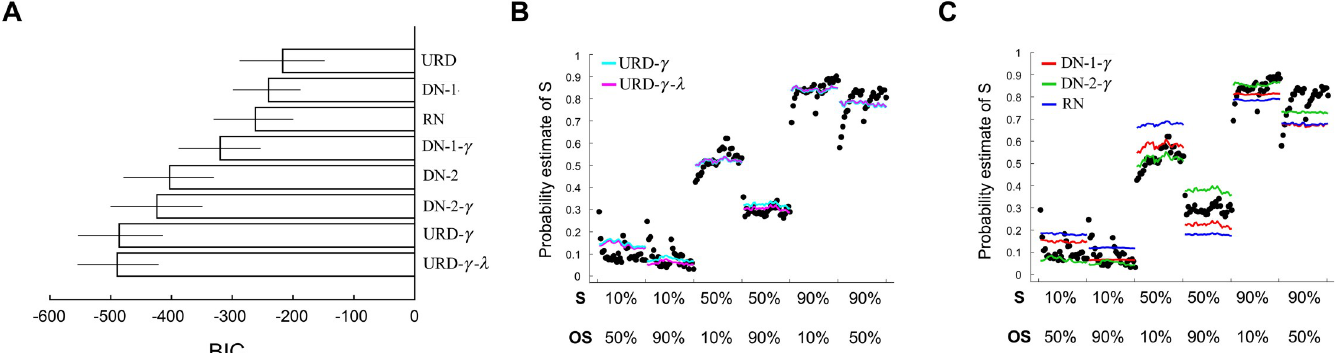
Fig 7. Model fitting results: Group average data. (A) Model comparison. We show BIC value of 8 models. Smaller BIC values indicate better models. Error bars represent 95% bootstrap confidence interval. (B) Model fitting results of the URD models (URD- γ ,URD- γ - λ ). (C) Model fitting results of the divisive normalization models (DN-1- γ ,DN-2- γ ) and range normalization model (RN). Each data point (black) in panels B and C represents the mean probability estimate (across all subjects) of a particular trial order. For example, in the [10%, 50%] context, when S is the 50% reward stimulus, OS would be the 10% reward stimulus; when S is the 10% reward stimulus, OS would be the 50% reward stimulus. Data underlying these graphs can be found in https://osf.io/48j7m. BIC, Bayesian information criterion; DN, divisive normalization; OS, the other stimulus present in the same context as the stimulus of interest; RN, range normalization; S, stimulus of interest; URD, uncertainty and reference